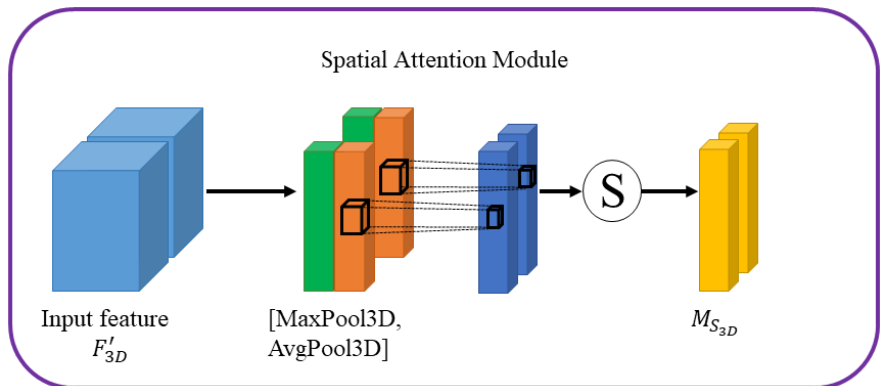
Figure 5. Diagram of the spatial attention module.